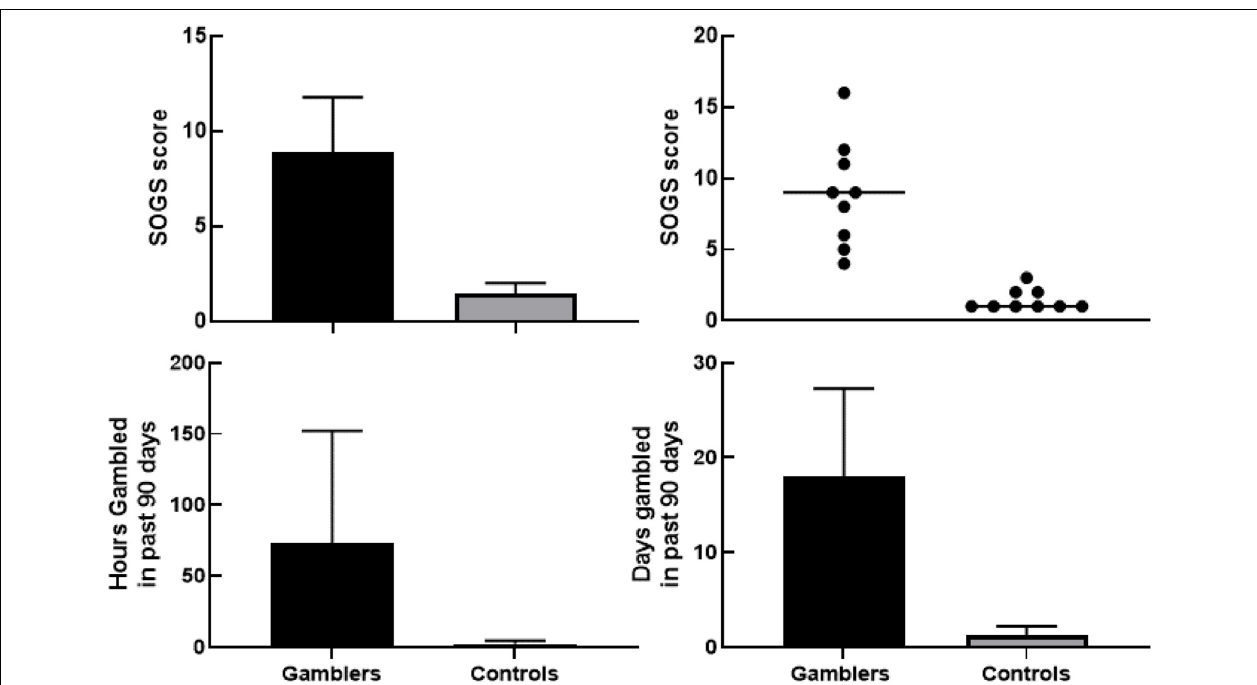
FIGURE 1 | Upper left panel shows group differences in South Oaks Gambling Screener between gamblers and controls with 95% confidence interval using an independent samples t -test with Welch’s correction [ t (16) = 5.837, p < 0.001]. Upper right panel shows scatterplot of individual South Oaks Gambling Screener values with the line representing median score per group. Bottom left panel shows group differences of number of hours gambled in the last 90 days with 95% confidence interval using a one-tailed independent samples t -test with Welch’s correction [ t (8) = 2.034, p = 0.038]. Bottom right panel shows group differences in number of days gambled in last 90 days with 95% confidence interval using a one-tailed independent samples t -test with Welch’s correction [ t (8) = 4.142, p <